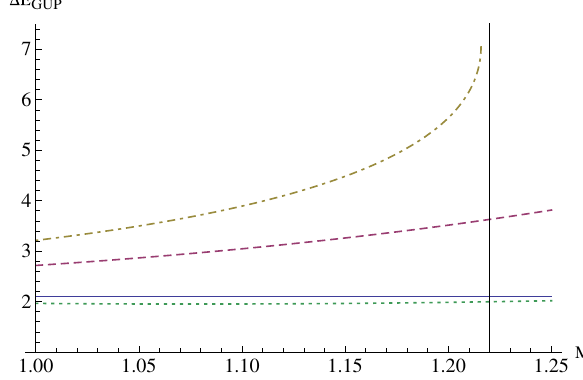
Fig. 1 In this figure, we have used Planck units, i.e., G = c = ¯ h = 1, so (cid:7) p = m − 1 p = 1. The solid line describes the case in which the energy (cid:2) E equals the black hole mass, i.e., M. The dashed line depicts the required energy when we consider the HUP, i.e. α = 0. The dotted dashed line depicts the required energy when the quadratic GUP is considered. Finally, the dotted line below the solid line provides the required energy (cid:2) E when the linear as well as the quadratic terms in momentum are present in the GUP. The GUP parameter has been set √ equal to α = 0 . 02